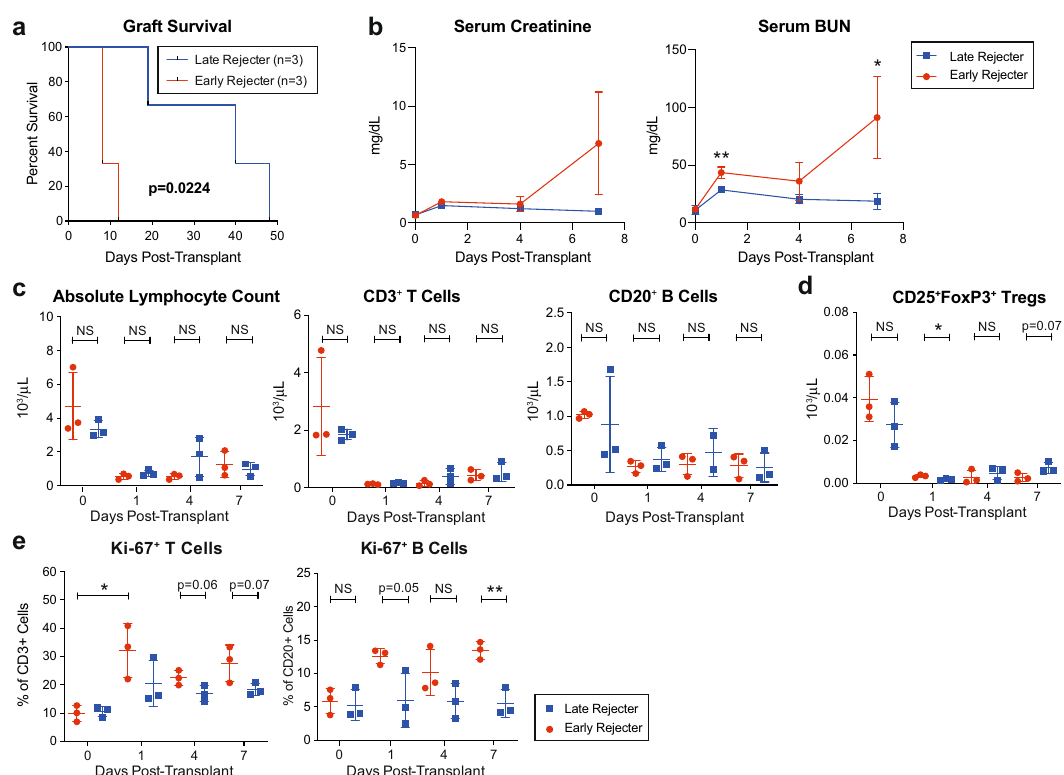
Fig. 5 A subgroup of Cp40-treated primates experienced graft failure while receiving treatment. a Kaplan – Meier curve of the graft survival of early rejecters (red, n = 3) and late rejecters (blue, n = 3). b Serum creatinine and blood urea nitrogen (BUN) levels during the fi rst week after kidney transplantation (day 0 – 7) of the early rejecter group (ER, n = 3) and late rejecter group (LR, n = 3). BUN level was signi fi cantly higher in ER group at post- transplant day 1 ( p = 0.0062) and 7 ( p = 0.025) compared to LR group. * p < 0.05; ** p < 0.01 using two-tailed parametric unpaired t test. c Absolute lymphocyte, CD3 + T cell and CD20 + B cell counts between the ER ( n = 3) and LR ( n = 3) groups. d Absolute Treg cell counts de fi ned as CD4 + CD25 + FoxP3 + T cells from ER ( n = 3) and LR ( n = 3) groups. Treg cell number was signi fi cantly higher in LR group at post-transplant day 1 ( p = 0.0434) compared to ER group. * p < 0.05 using two-tailed parametric unpaired t test; NS indicates no statistical signi fi cance. e Frequency of Ki-67 + proliferating CD3 + T cells and CD20 + B cells ER ( n = 3) and LR ( n = 3) groups. T cell proliferation was signi fi cantly increased in ER group (day 0 vs. day 1; p = 0.0399). Frequency of proliferating B cells were signi fi cantly higher in ER group at post-transplant day 7 ( p = 0.0051). * p < 0.05 using two-tailed parametric paired t test; ** p < 0.01 using two-tailed parametric unpaired t test; NS indicates no statistical signi fi cance. All data are presented as mean ± SD; N number indicates biologically independent